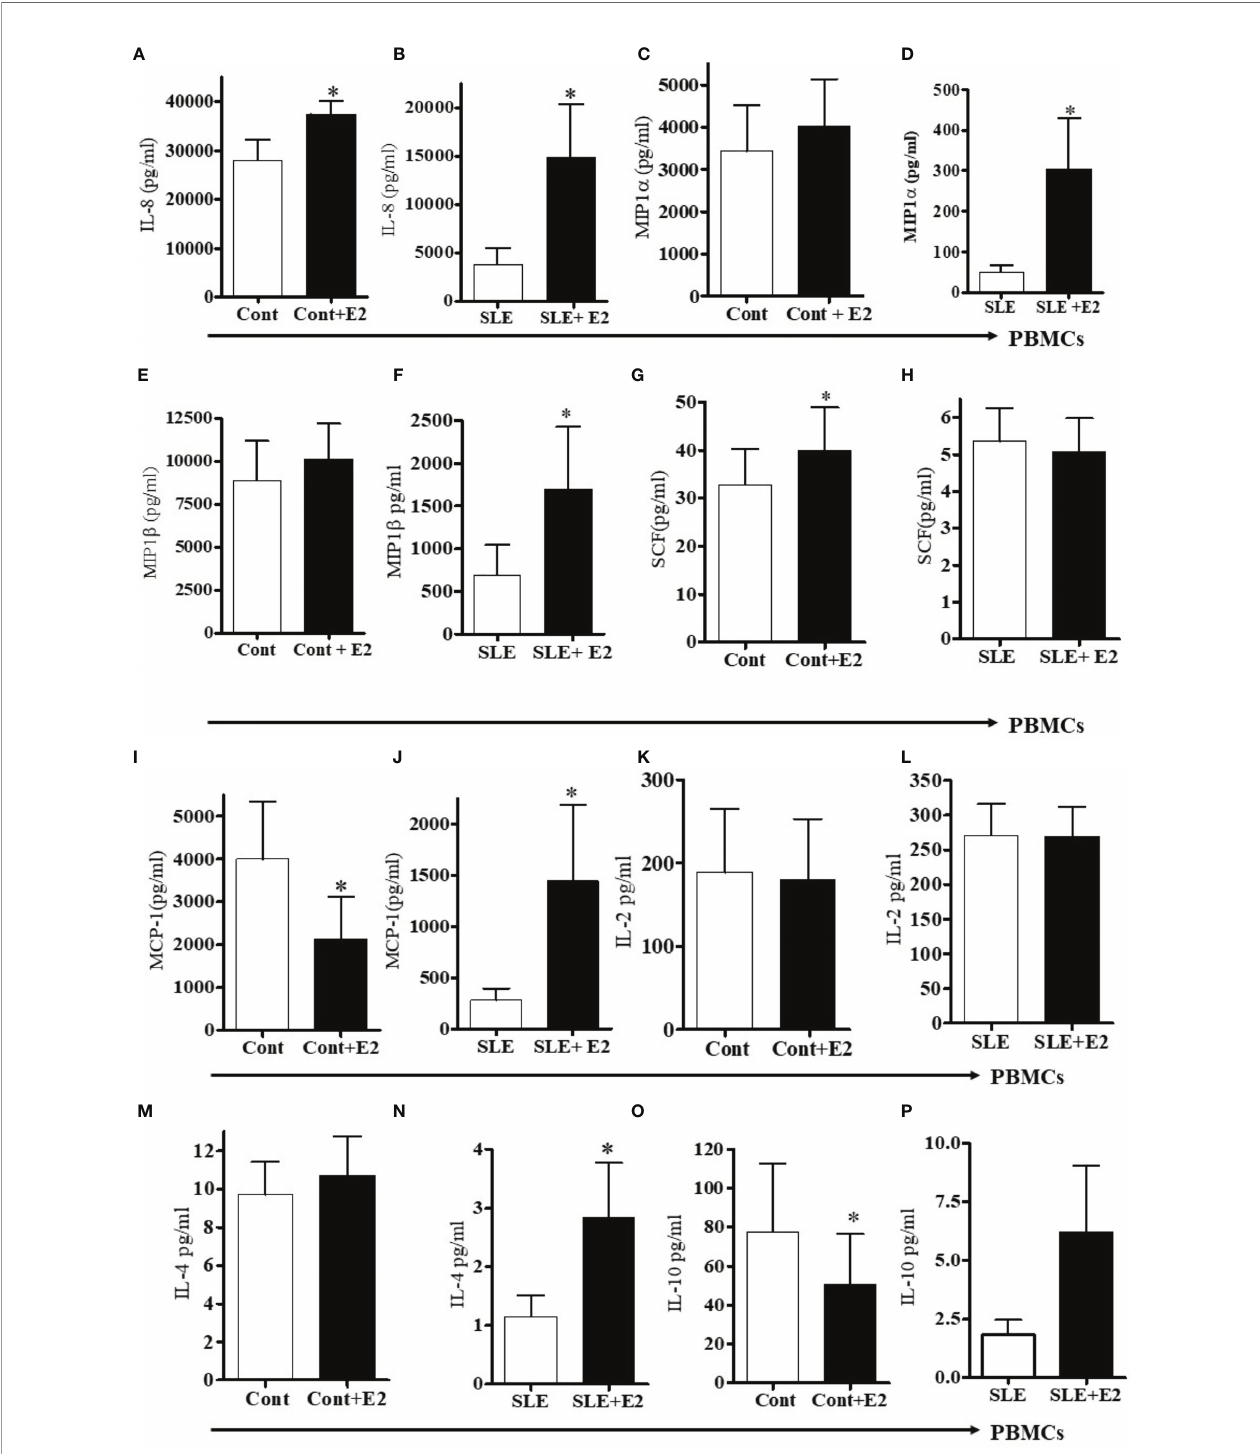
FIGURE 5 | 17 b -estradiol increases pro-in fl ammatory chemokines in both healthy control and SLE patients ’ PBMCs. PBMCs of female healthy controls and female SLE patients were cultured with 17 b -estradiol (50 pg/ml) for 24-48h range (n=10-12). Culture supernatants were obtained and levels of IL-8 (A, B) , MIP1 a (C, D) , MIP1 b (E, F) , SCF (G, H) MCP-1 (I, J) , IL-2 (K, L) , IL-4 (M, N) , and IL-10 (O, P) were measured by multiplex assays (MAP). Conditions: (A, C, E, G, I, K, M, O) . Healthy female control cells (PBMCs), Healthy female control cells + E2 (50 pg/ml) n=11, (B, D, F, H, J, L N, P) . SLE female patient cells (PBMCs), SLE female patient cells + E2 (50 pg/ml) n=10. *p <